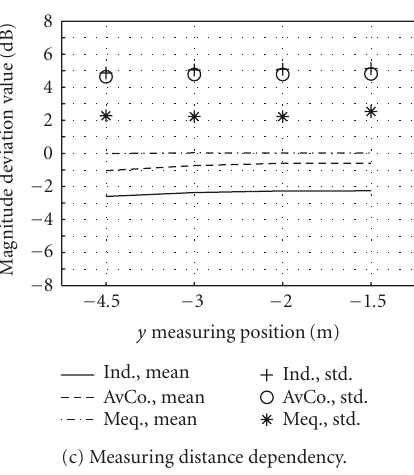
Figure 12: Mean value (mean) and standard deviation (std) of evaluated below the aliasing frequency for all microphone MAG Ψ m and source positions. Comparison between individual equalization (Ind), individual equalization + average synthesis error compensa- tion (AvCo), and multichannel equalization (Meq) for ideal loud- speakers.